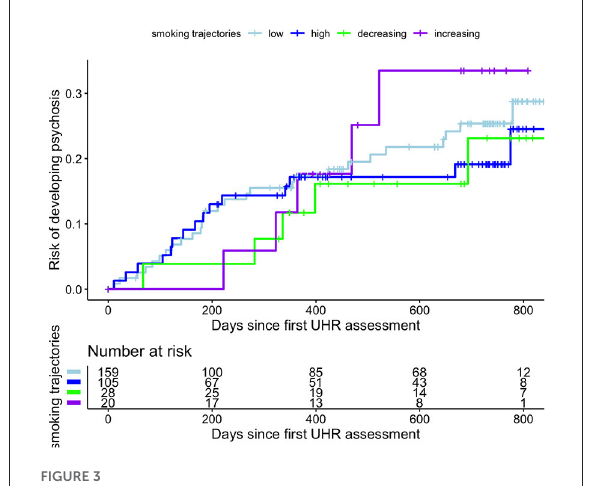
FIGURE3 Cumulative event Kaplan–Meier function for risk of development of psychotic disorders in 312 ultra-high risk (UHR) individuals stratified for smoking trajectory class.